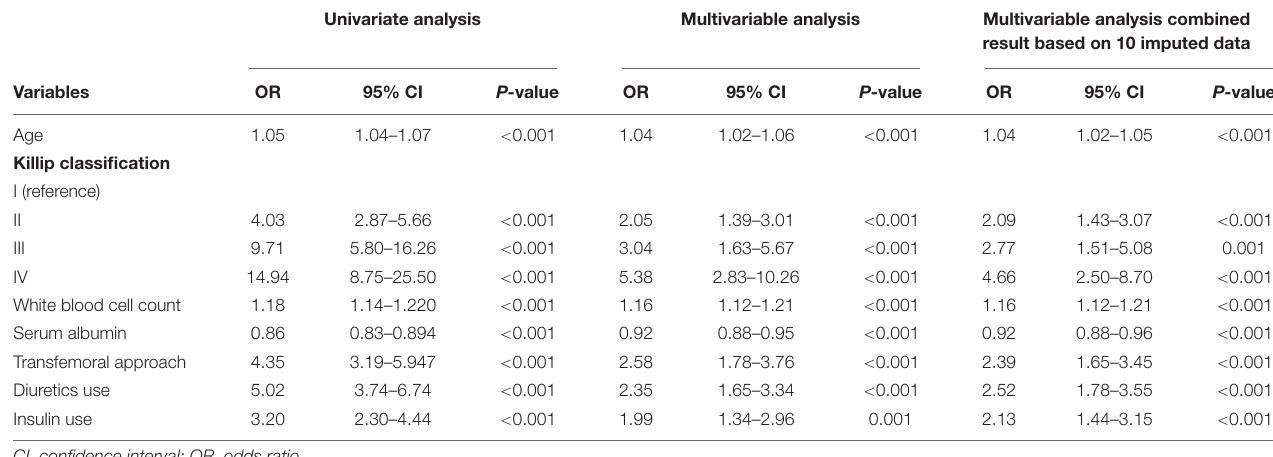
TABLE 2 | Univariate and multivariable logistic regression analysis of risk factors that were selected to develop the risk model for predicting post-AMI infection in the development cohort. Univariate analysis